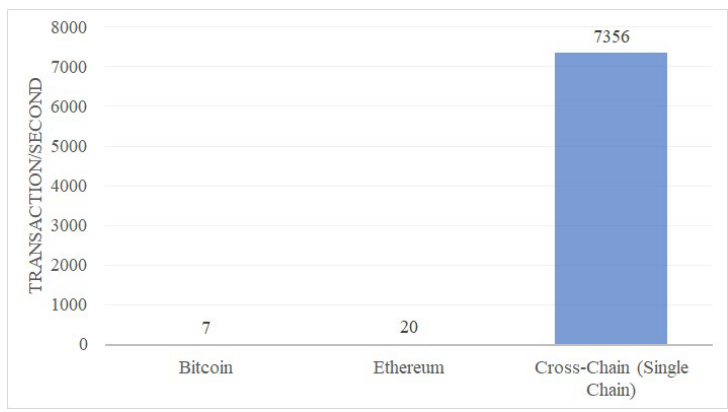
Figure 11. Compare with Bitcoin and Ethereum.